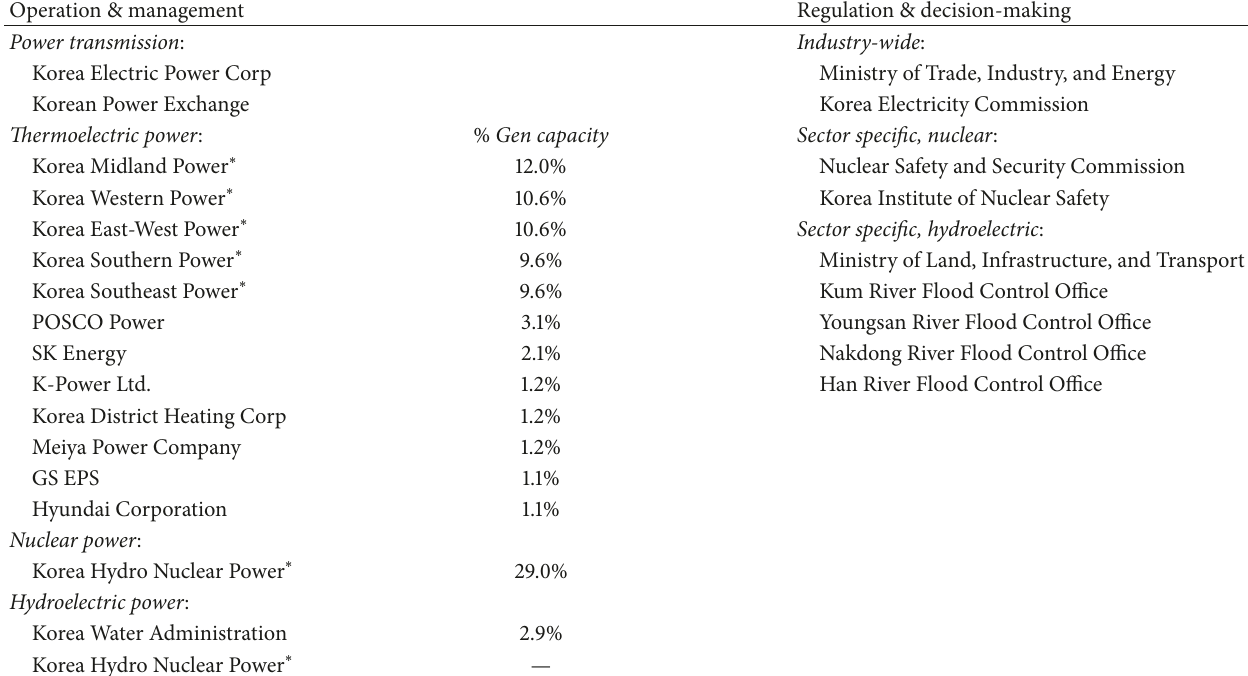
Table 1: Electric power industry organizations.